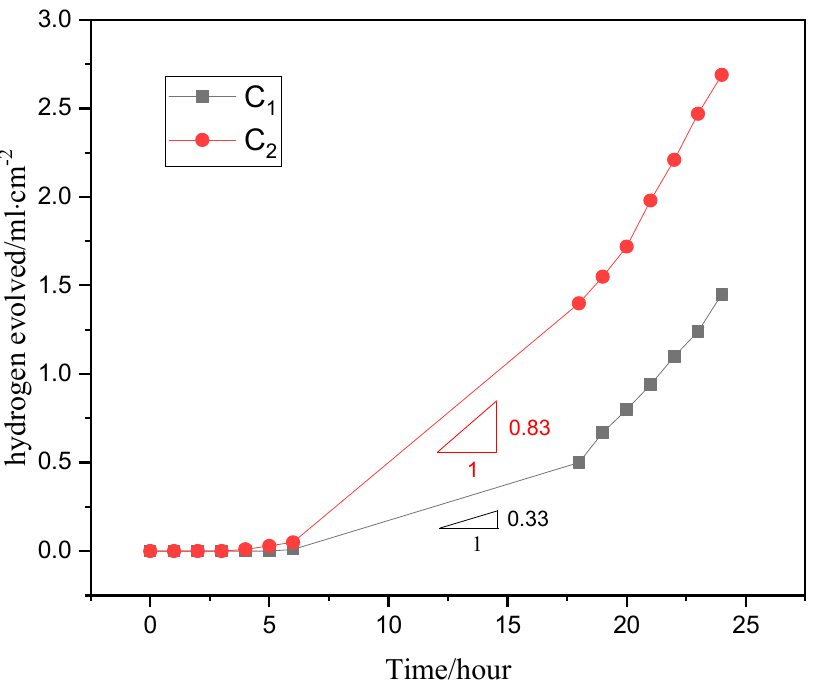
Figure 4. Volume of hydrogen evolution versus time curves of C 1 and C 2 samples measured in 3.5 wt.% NaCl solution.